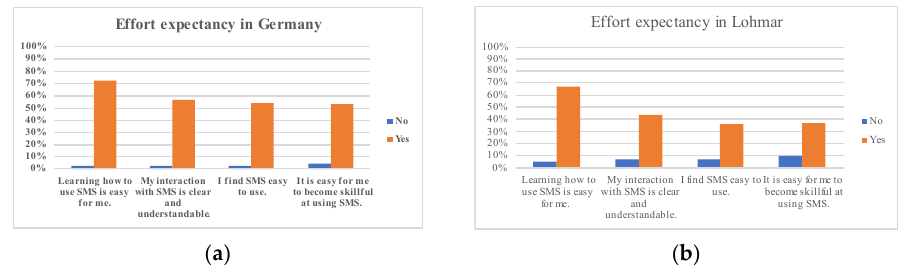
Figure 6. Effort Expectancy (EE): ( a ) Germany vs. ( b ) Lohmar.